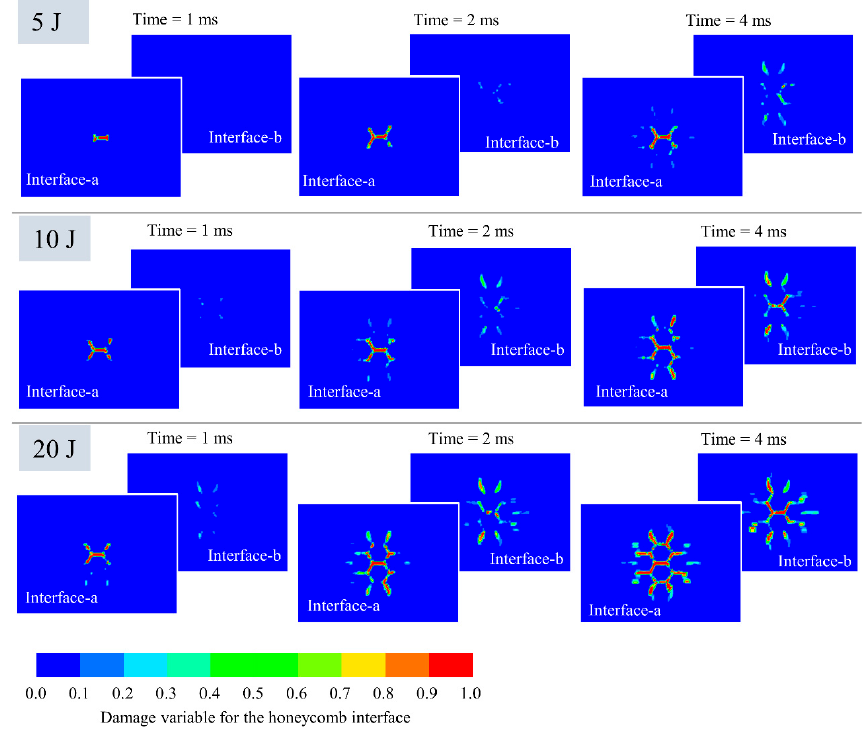
Figure 12. Evolution of interface damage variables of face-sheet/core under impact.